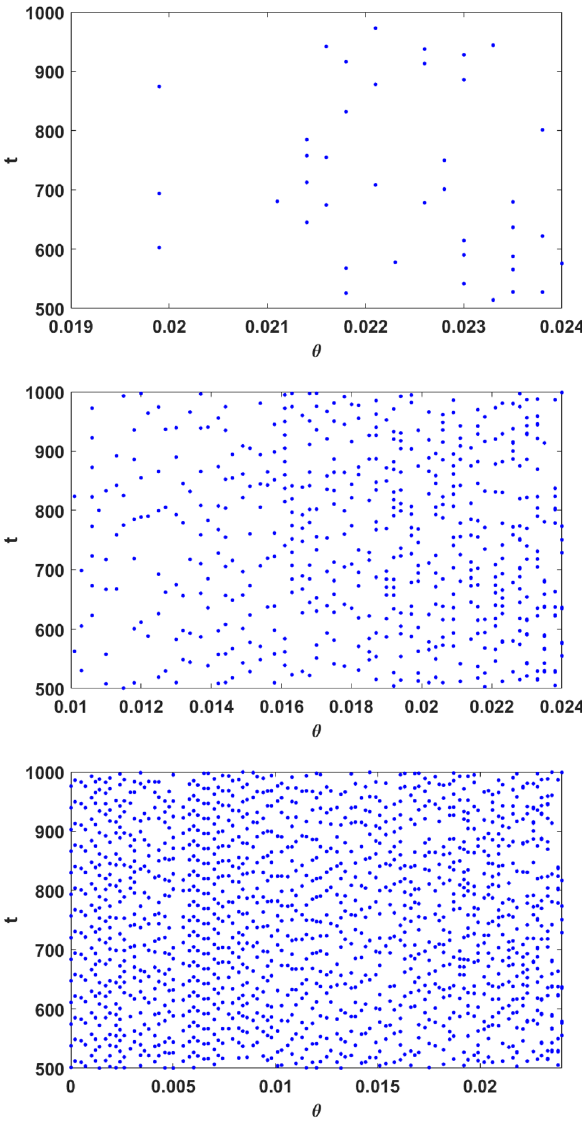
Figure 4. Figure marking the time instances at which a population exceeds the 7 σ threshold, for different values of Allee parameter θ , for the case of (top to bottom) vegetation, prey and predator